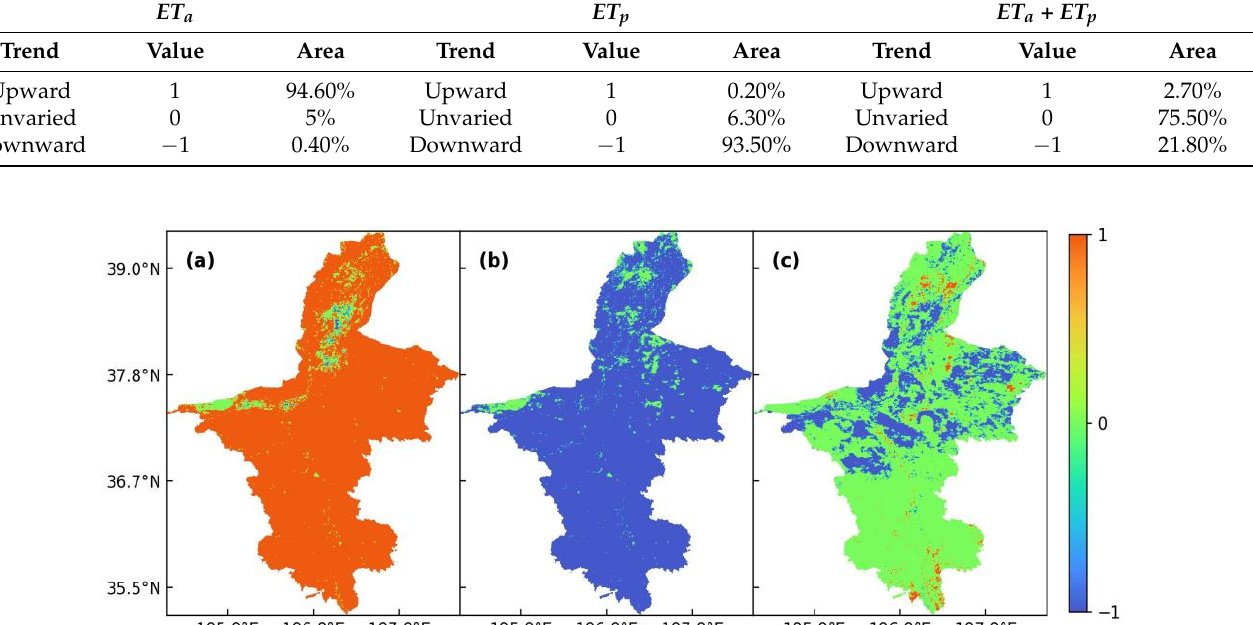
Figure 3. Trends of spatial variation in AET, PET and the sum of AET and PET in Ningxia from 2001 to 2020. ( a – c ) Spatial distribution of AET ( a ), PET ( b ) and the sum of AET and PET ( c ) trends.